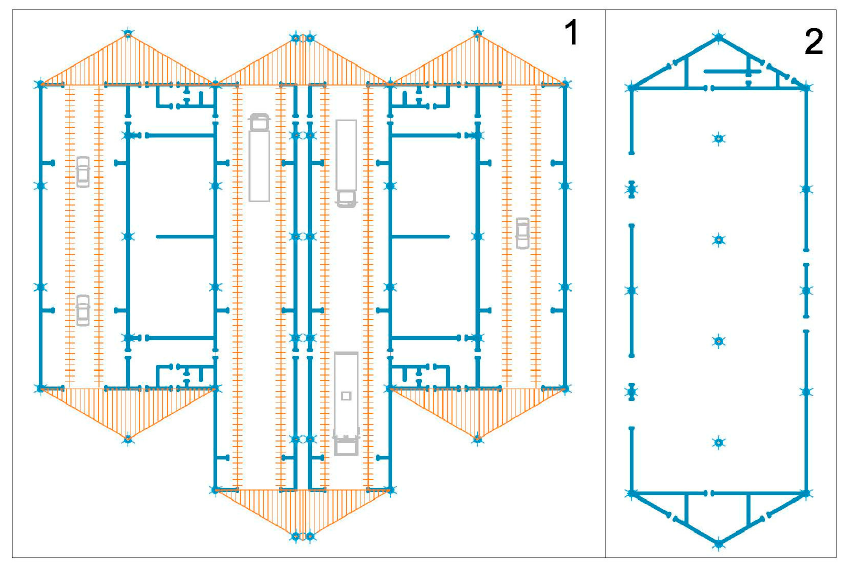
Figure 10. Planning solutions: 1—the Contactless car wash (4 posts); 2—the Warehouse.